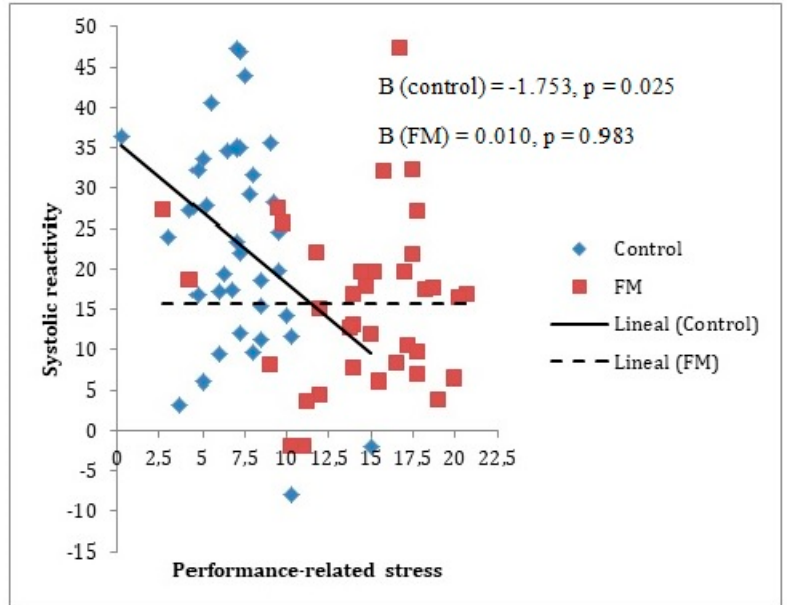
Figure 2. Group moderating role between a systolic reactivity measure and Performance-related stress factor. The reactivity index is represented as the di ff erence between the baseline and the stress measurements (task minus baseline). In the figure, the lines represent raw scores. As can be observed, only in the control group does systolic pressure reactivity decrease significantly when Performance-related stress factor levels increase. Note: FM = fibromyalgia; Systolic reactivity is measured in mmHg = millimeters of mercury.